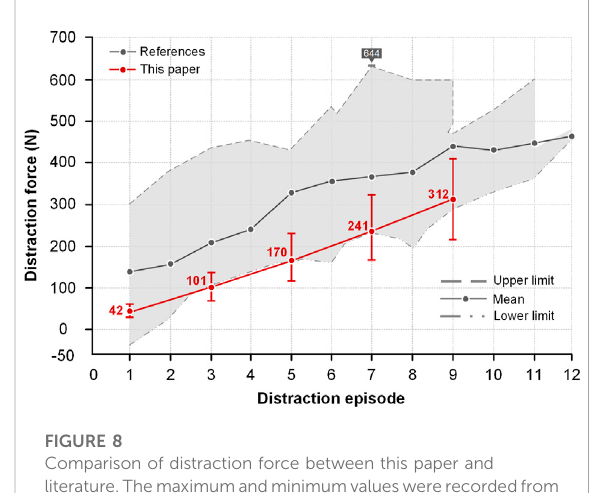
FIGURE 8 Comparison of distraction force between this paper and literature.Themaximumandminimumvalueswererecordedfrom the literature and were merged into a gray region. The upper boundary of the gray region represented the largest distraction force and the lower boundary represented the smallest one. Accordingly, the gray line represents the mean force value in